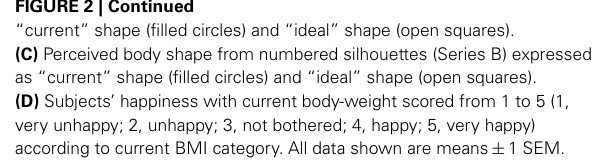
(C) Perceived body shape from numbered silhouettes (Series B) expressed as “current” shape (filled circles) and “ideal” shape (open squares). (D) Subjects’ happiness with current body-weight scored from 1 to 5 (1, very unhappy; 2, unhappy; 3, not bothered; 4, happy; 5, very happy) according to current BMI category. All data shown are means ± 1